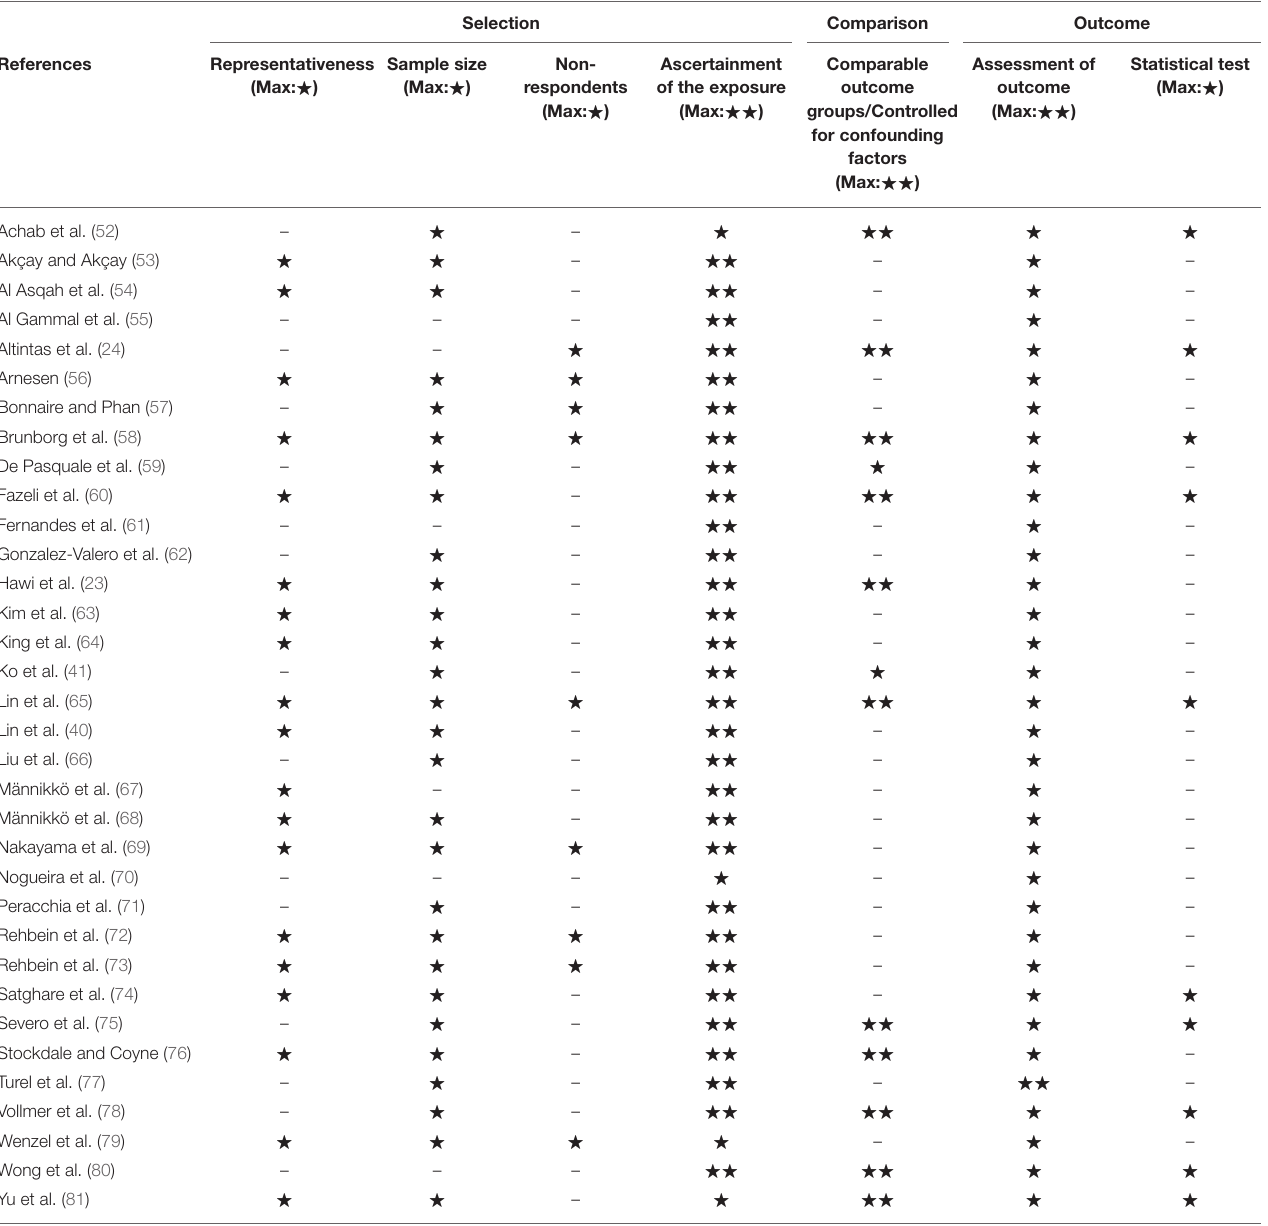
TABLE 3 | Results from the Newcastle-Ottawa quality